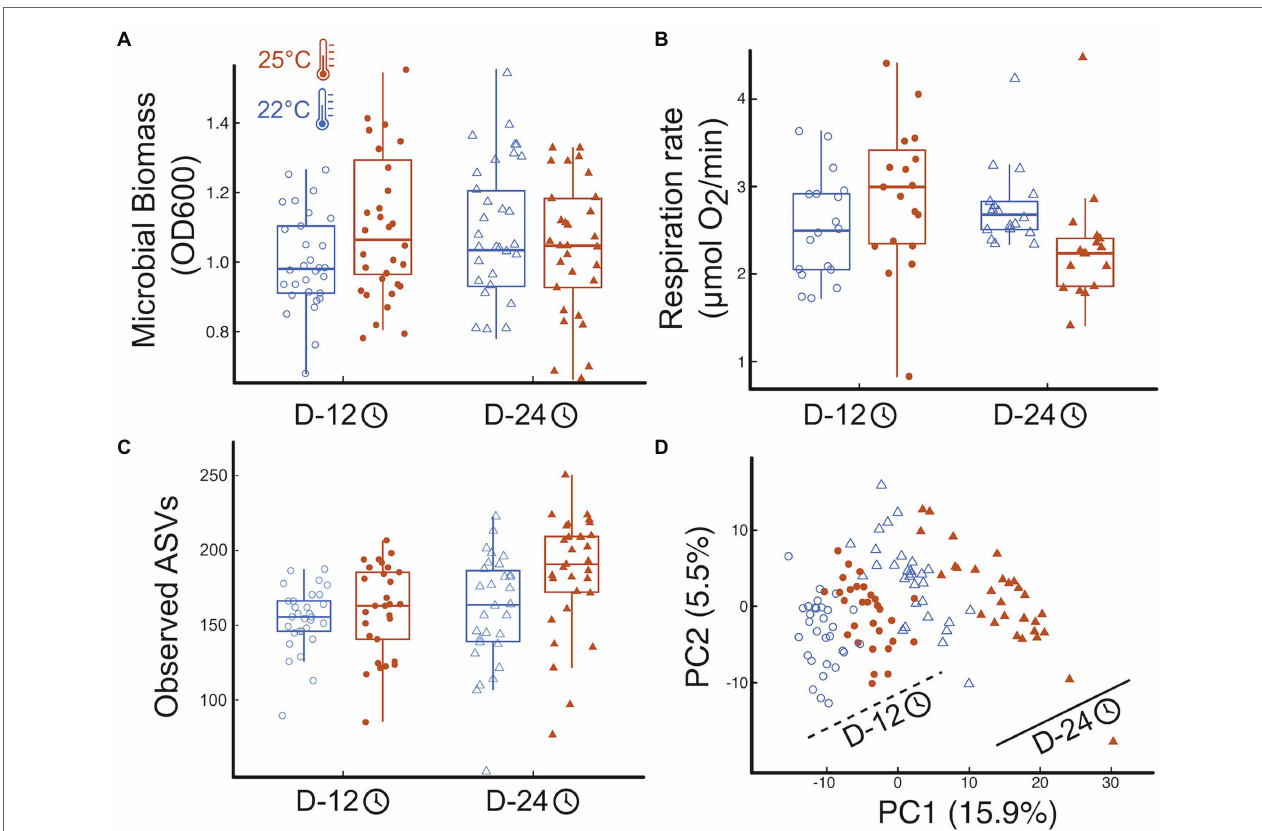
FIGURE 1 | Temperature impacts on microbial function and community structure. (A) Boxplots of the treatment effects on total microbial biomass, (B) the effects on total microbial respiration, here as oxygen consumption, (C) the effects on microbial community richness, here observed ASVs (see Fig S5 for other diversity indices), and (D) the effects of temperature and time on the microbial community structure (microbial abundance inferred from sequence data). Shapes represent incubation time: Day12—circles, Day 24—triangles; temperature marked by point fill: 22 ° C—empty point, 25 ° C—color filled point. Panels include all data pooled across protist and no protist